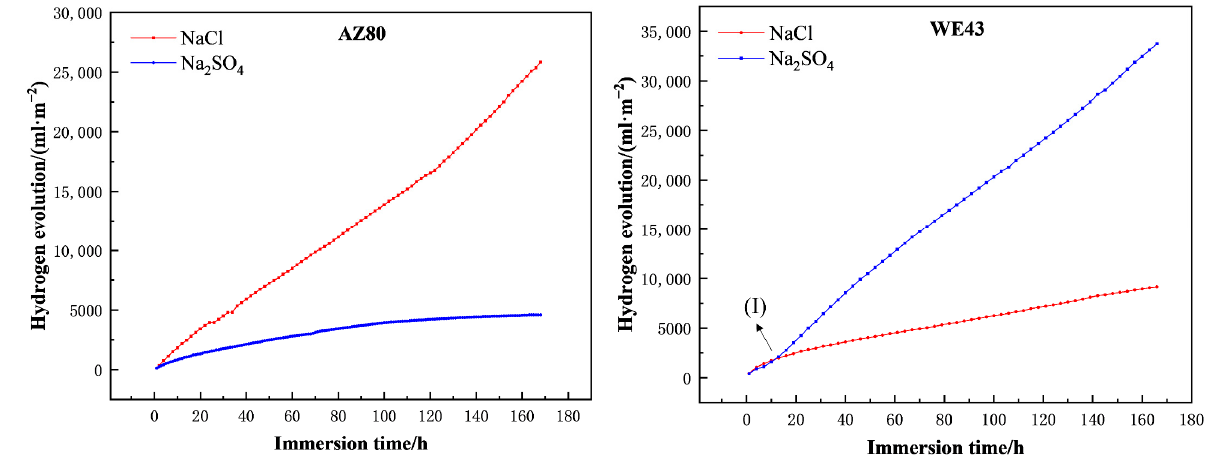
Figure 8. The hydrogen evolution of AZ80 and WE43 in NaCl and Na 2 SO 4 .